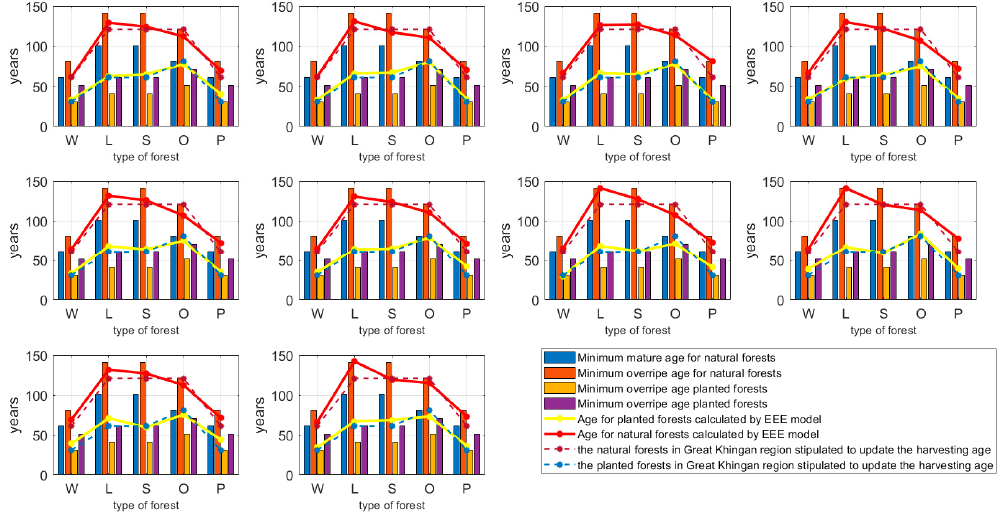
Figure 4. Regeneration cutting ages of the natural and planted forests in the Great Khingan region.